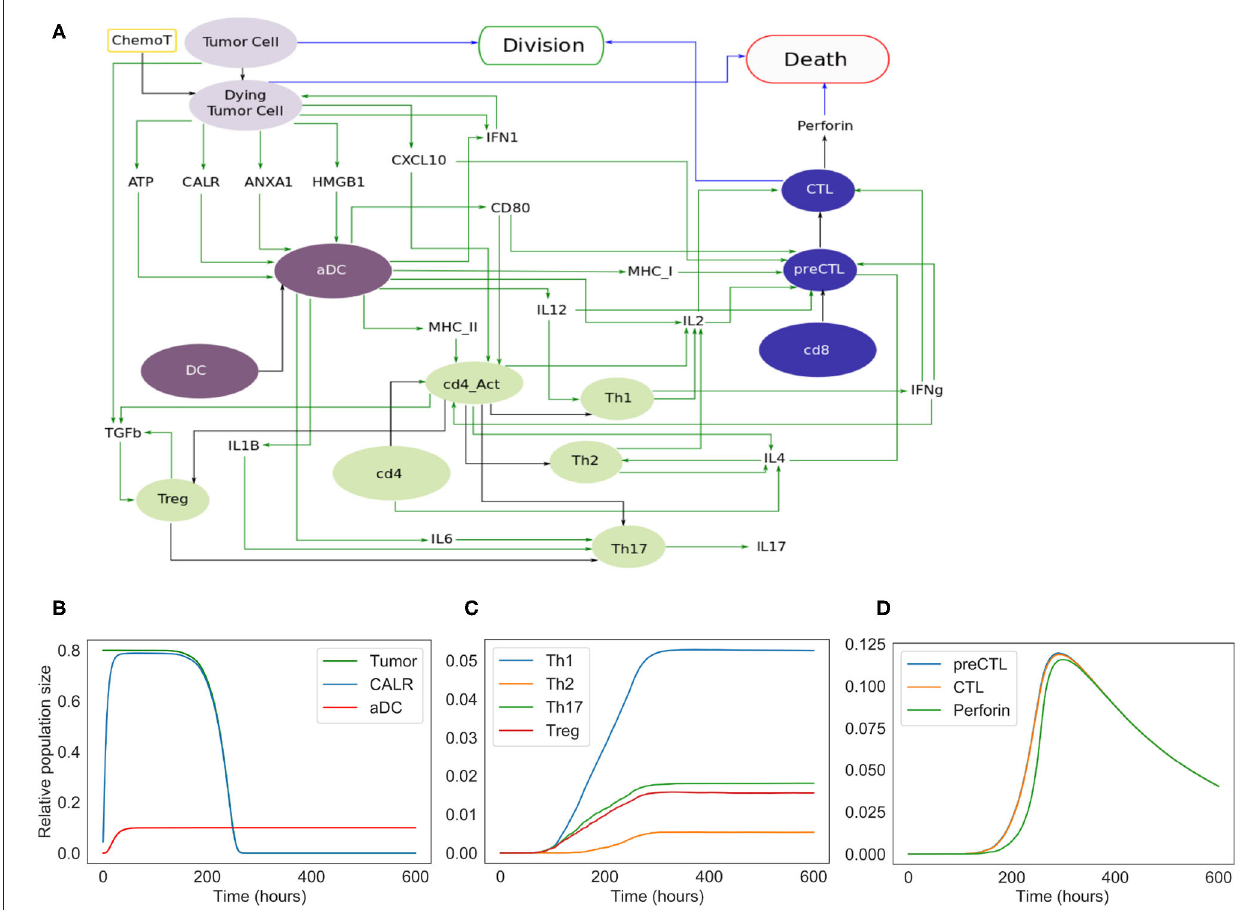
FIGURE 3 | Extended model. (A) Influence network of the extended version of ICD involving four cell types: tumor cells (light purple nodes), dendritic cells (dark purple nodes), CD4 + T cells (green nodes) and CD8 + T cells (blue nodes). Green arcs correspond to activation, black arcs to cell transformation, and blue arcs to cell fate interactions. Tumor Cell, DC, cd4, and cd8 are inputs. When the fifth input, namely ChemoT, is active, we consider that cells have incorporated a chemotherapeutic drug. The two cell fates, Division and Death, are outputs of the model. (B) Kinetics of the populations of tumor and active dendritic cells, as well as of CALR surface exposure. (C) Kinetics of the helper and regulatory CD4 + T cell subpopulations. (D) Kinetics of the CD8 + T cell subpopulations.